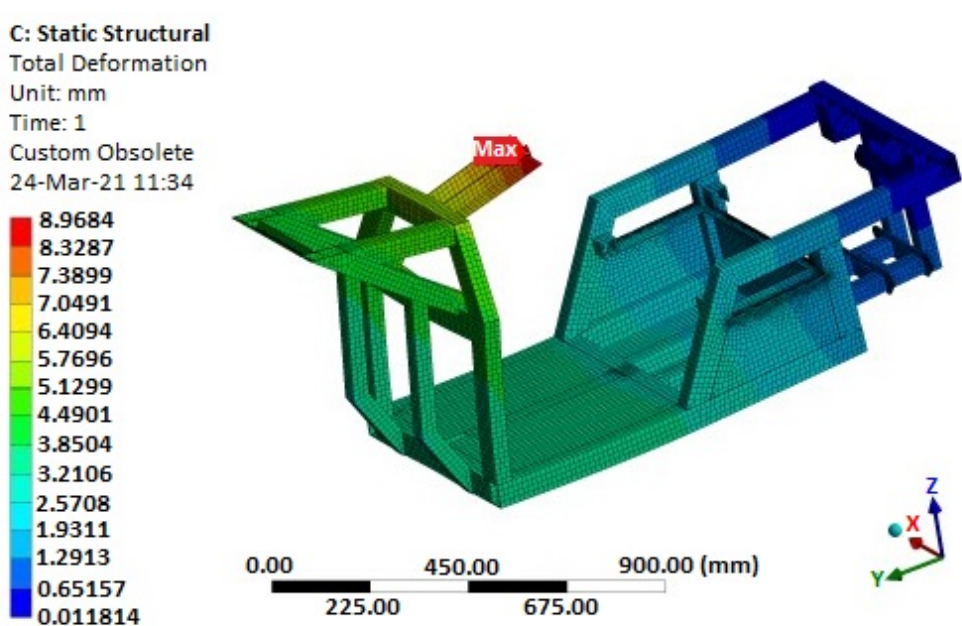
Figure 20. Simulated deformation of the E3-cycle frame at maximum state of stress.